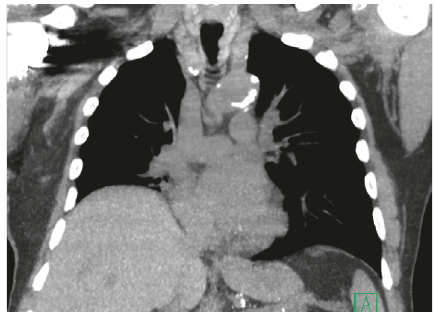
Figure 2: Chest CT scan 6 weeks